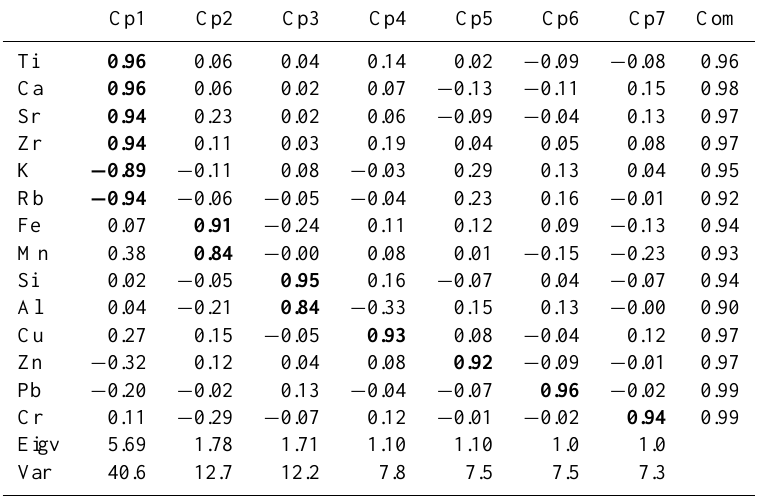
Table 1. Loadings of the chemical elements used in the principal components analysis. Cp1 to Cp7 – components; Com – communality (i.e. proportion of the variance of each element explained by the extracted components); Eigv – eigenvalue, Var – percentage of explained variance by each component.